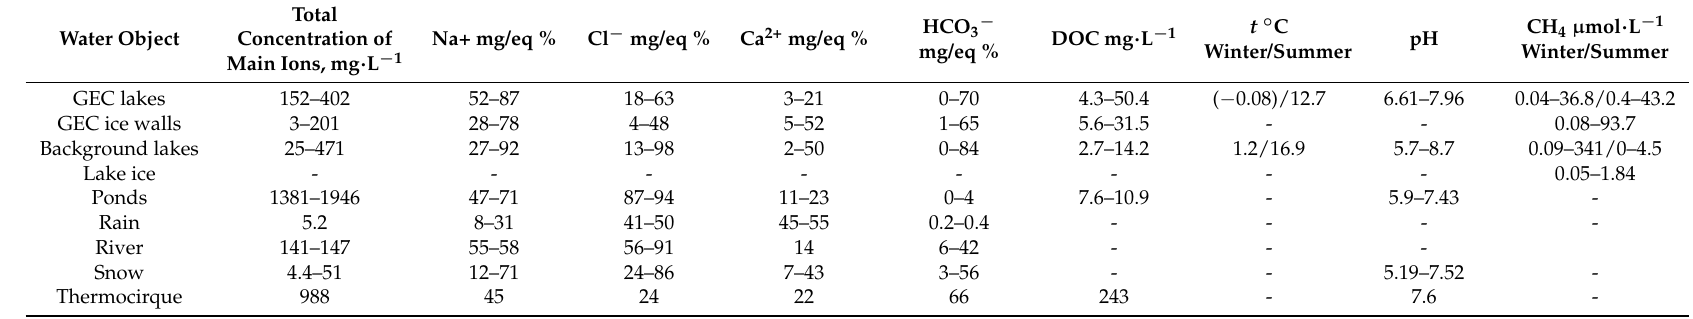
Table 1. The geochemical parameters of the water in various water bodies of the Yamal peninsula. The range is summarized for the 2014–2017 sampling years. Water